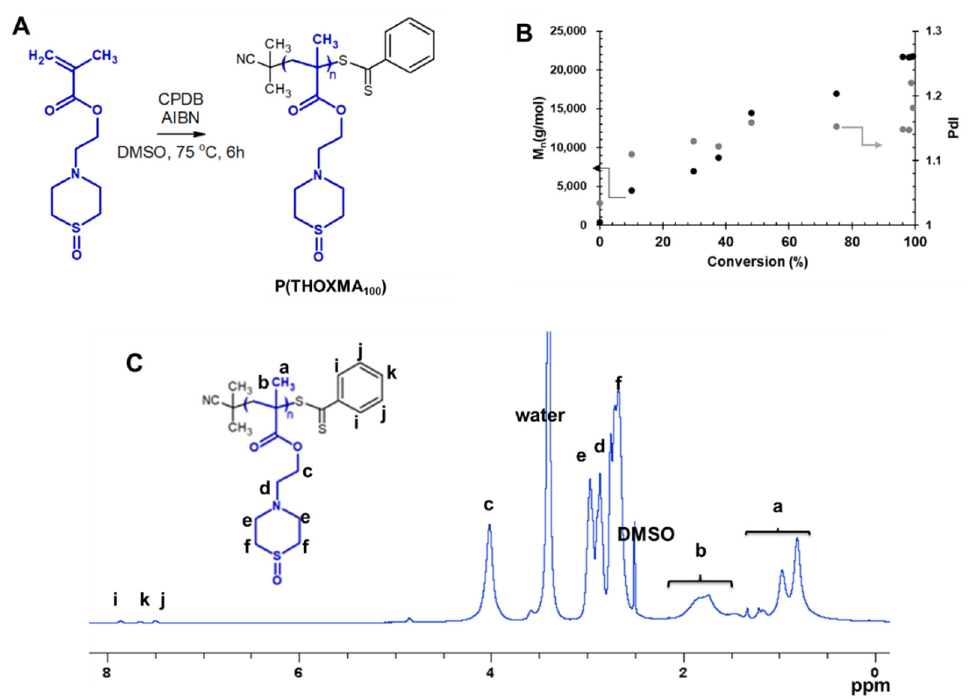
Figure 2. Synthesis of P(THOXMA 100 ) ( A ); evolution of M n and dispersity with conversion during the polymerisation of THOXMA (entry 1, Table 1) evaluated by SEC ( B ); 1 H-NMR spectrum of P(THOXMA 100 ) in DMSO d6 ( C ).